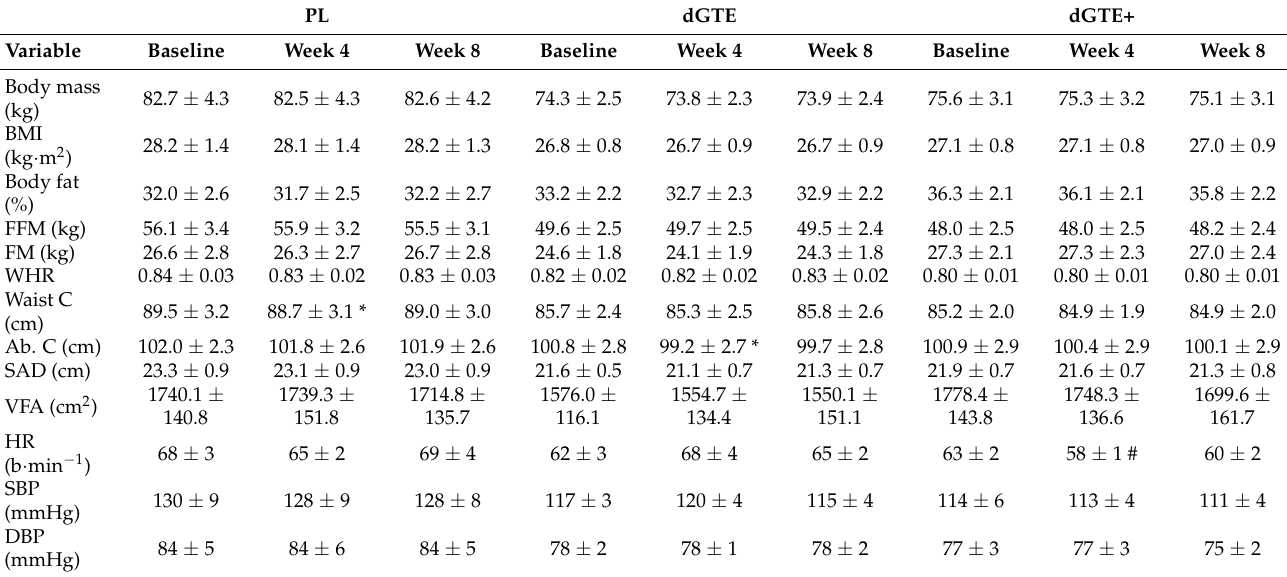
Table 6. Body composition, resting heart rate and blood pressure measures at baseline (week 0), week 4 and 8 between intervention